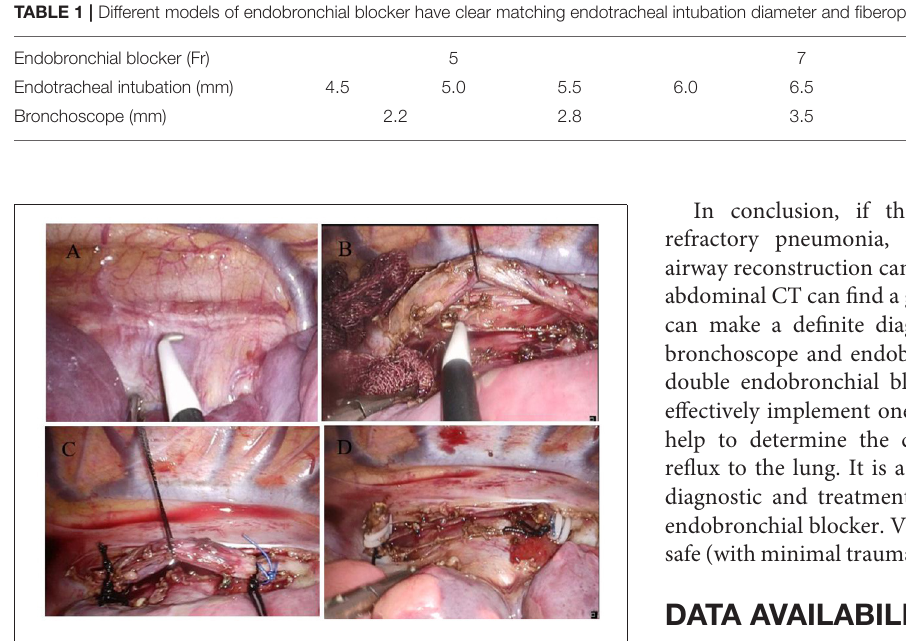
FIGURE 4 | Video-assisted thoracoscopic surgery to cut and suture the fistula. (A) CBBF was detected. (B) Free CBBF. (C) Ligation of CBBF. (D) CBBF was cut and